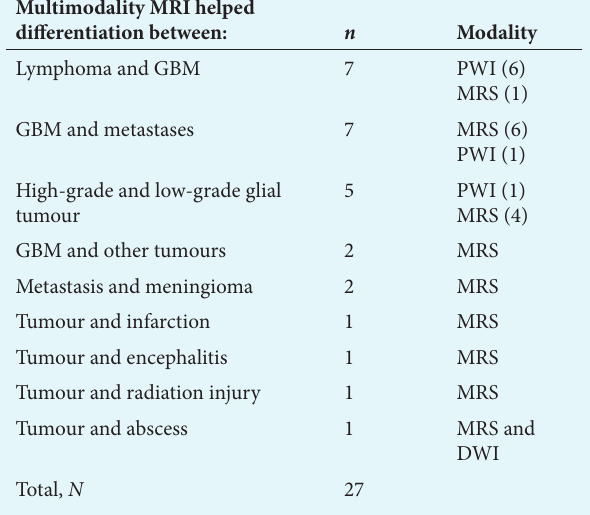
Table 3. The added utility of multimodal